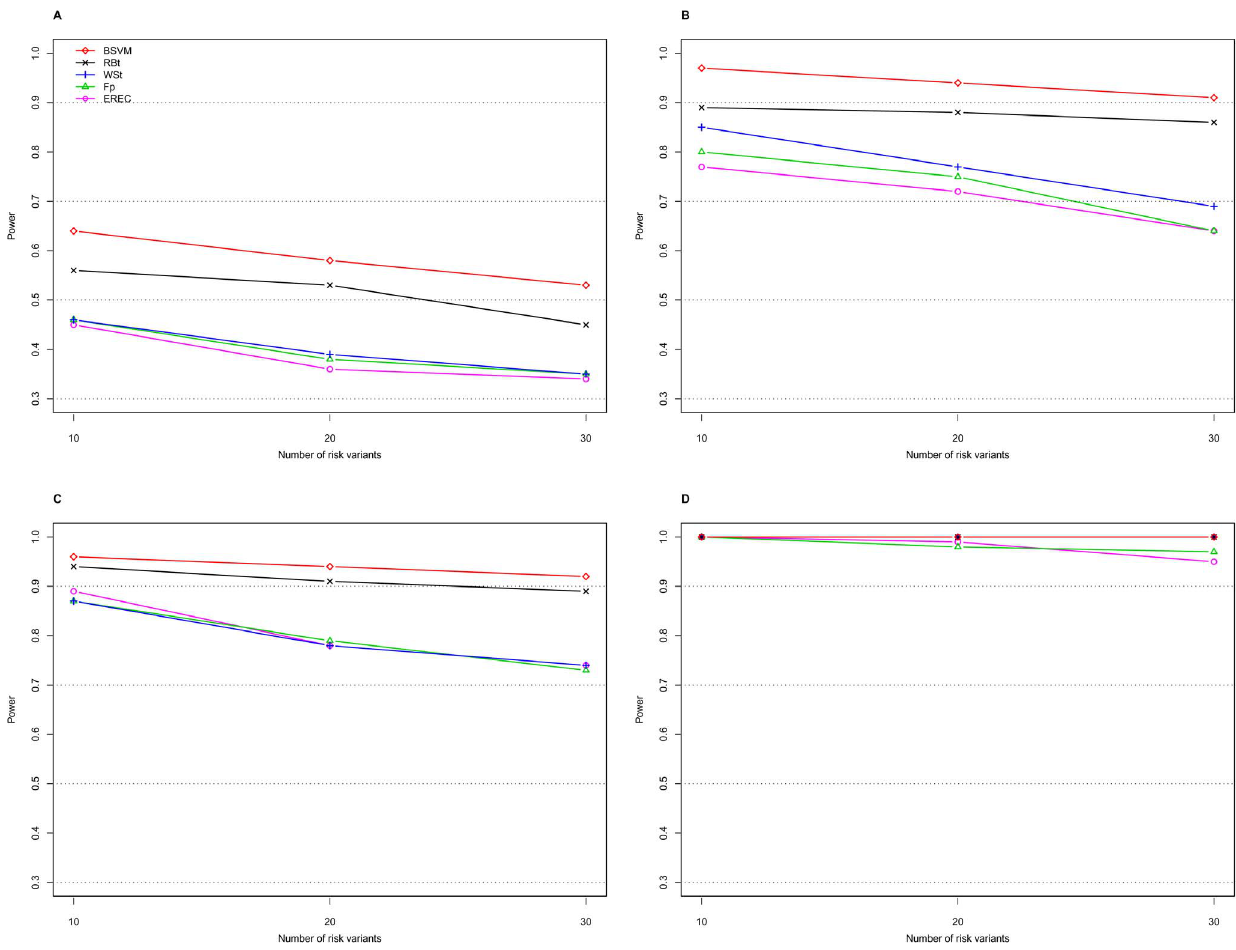
Figure 2. Power of the five approaches with unequal PARs in the presence of different numbers of risk variants. A. PAR=0.03 with a sample size of 1000; B. PAR=0.05 with a sample size of 1000; C. PAR=0.03 with a sample size of 2000; D. PAR=0.05 with a sample size of 2000. The nominal level is 0.05.